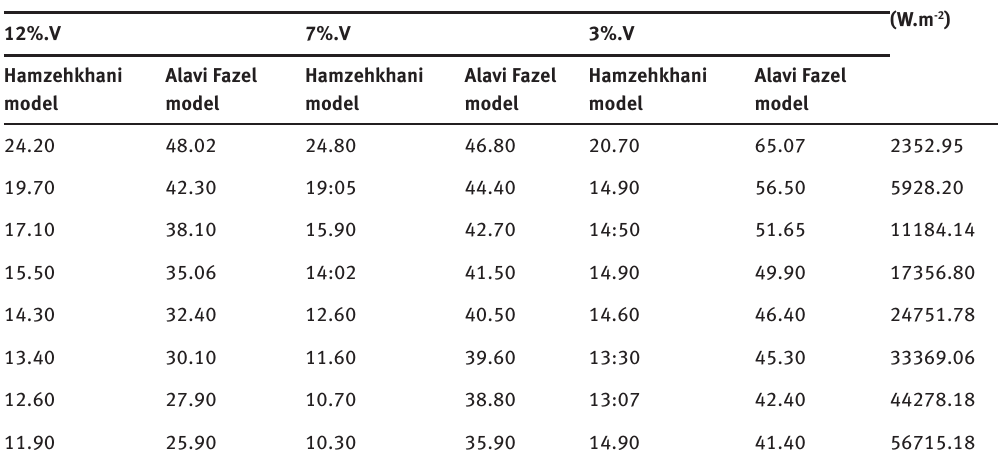
Table 1: The absolute average error (A.A.E) evaluation by the theoretical models for different volumetric percentage of water-ethanol solution at various heat